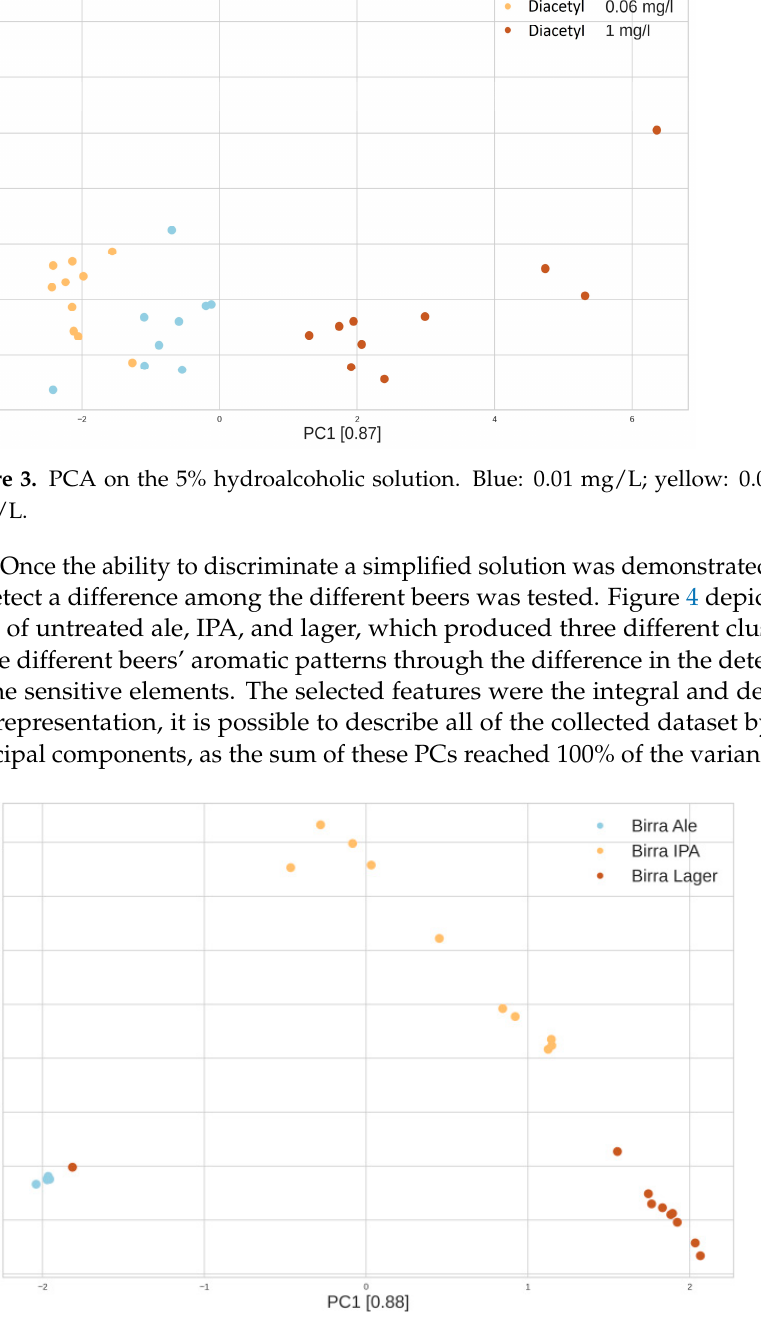
Figure 4. PCA obtained by the different types of beer. Light blue dots: ale; yellow dots: IPA; brown dots: lager. As described, the second part of the analysis was focused on investigating the S3+ device’s discriminant capacity in the beer samples. We performed 19 different tests and compared the results of different types of beers and different diacetyl concentrations. The results of the analysis show that the S3+ device is able to detect differences in molecule concentrations at levels that are smaller than explained variance on the outcome PCA. Indeed, two different clusters are visible in the IPA samples. how the device is able to recognize even very small differences among the samples. The selected features were mean and difference.